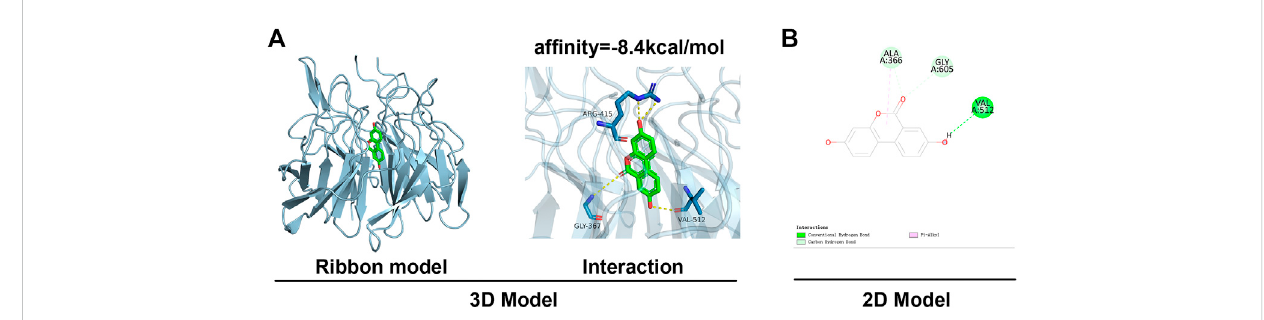
FIGURE 6 MD analysis showed that UA binds to Nrf2. (A) Ribbon and space- fi lling models of UA with Nrf2-Keap1 complex. (B) 2D binding models of UA with Nrf2-Keap1